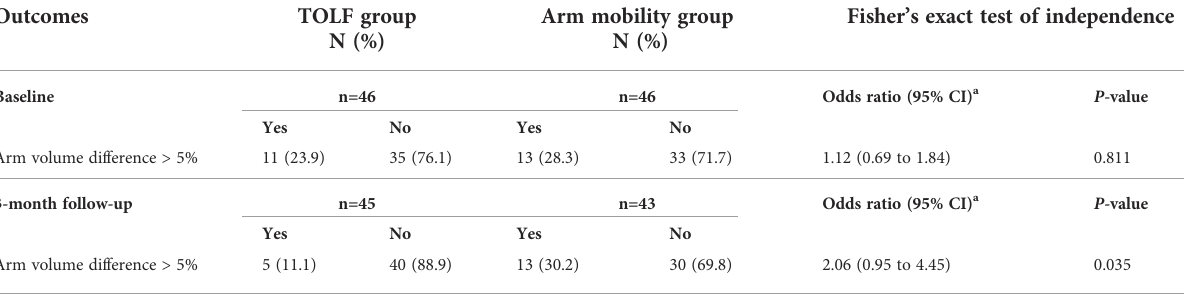
TABLE 5 Comparison of arm volume differences between the TOLF intervention group and arm mobility control group at baseline and study endpoint. Outcomes